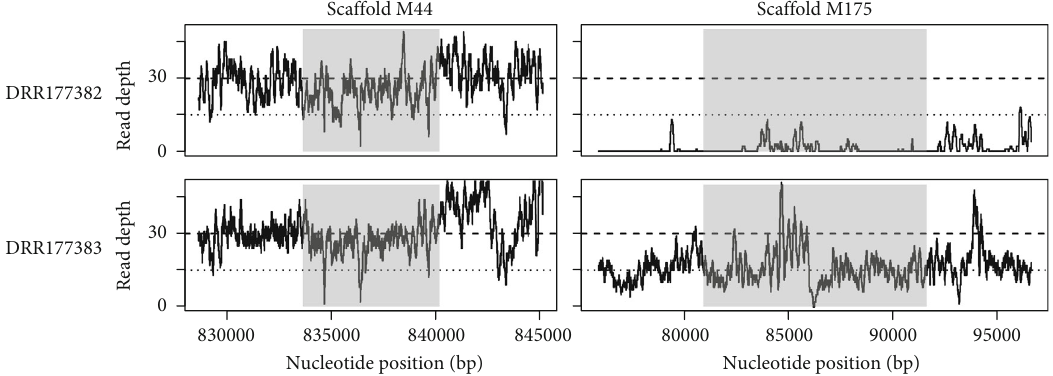
Figure 3: Mapped read depths around SLRs in resequenced PBT samples. For each of the female (accession no. DRR177382) and male (accession no. DRR177383) samples, SLR is highlighted in gray. The read depths for all the 31 samples are shown in Supplementary Figure